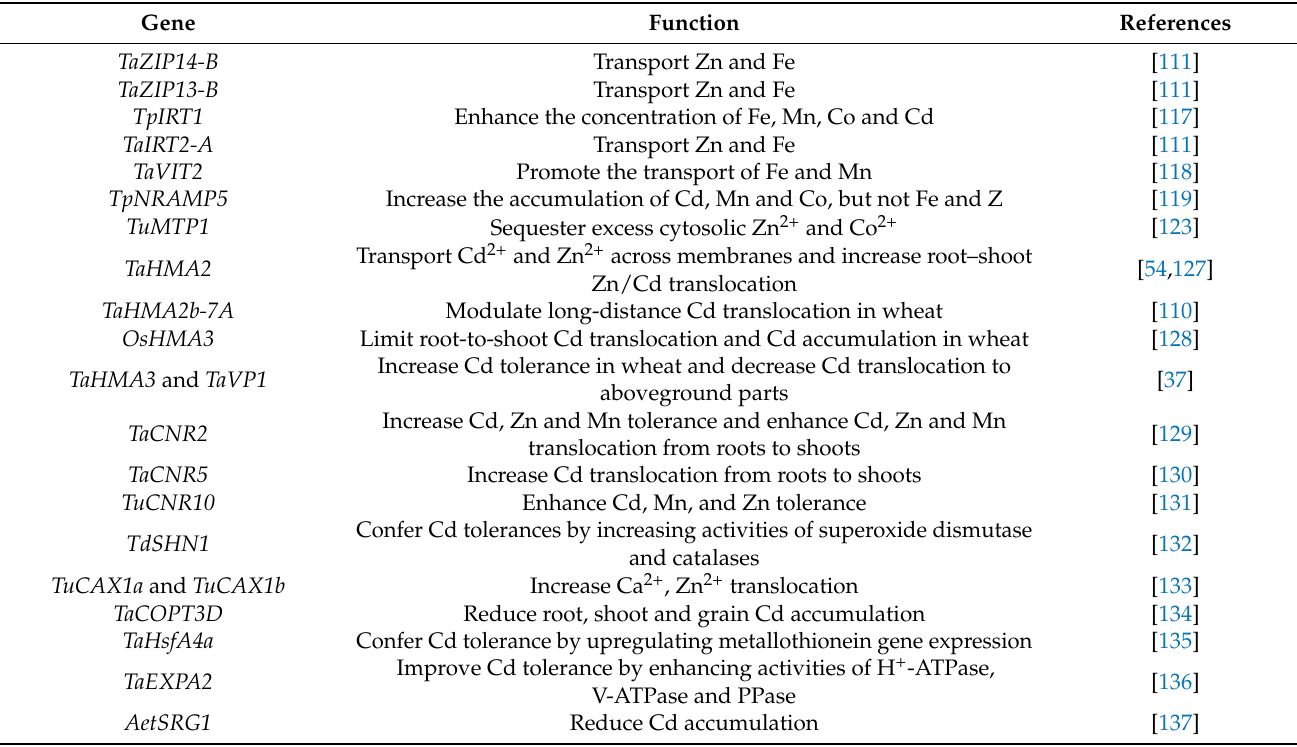
Table 1. Functional genes in wheat under heavy metal